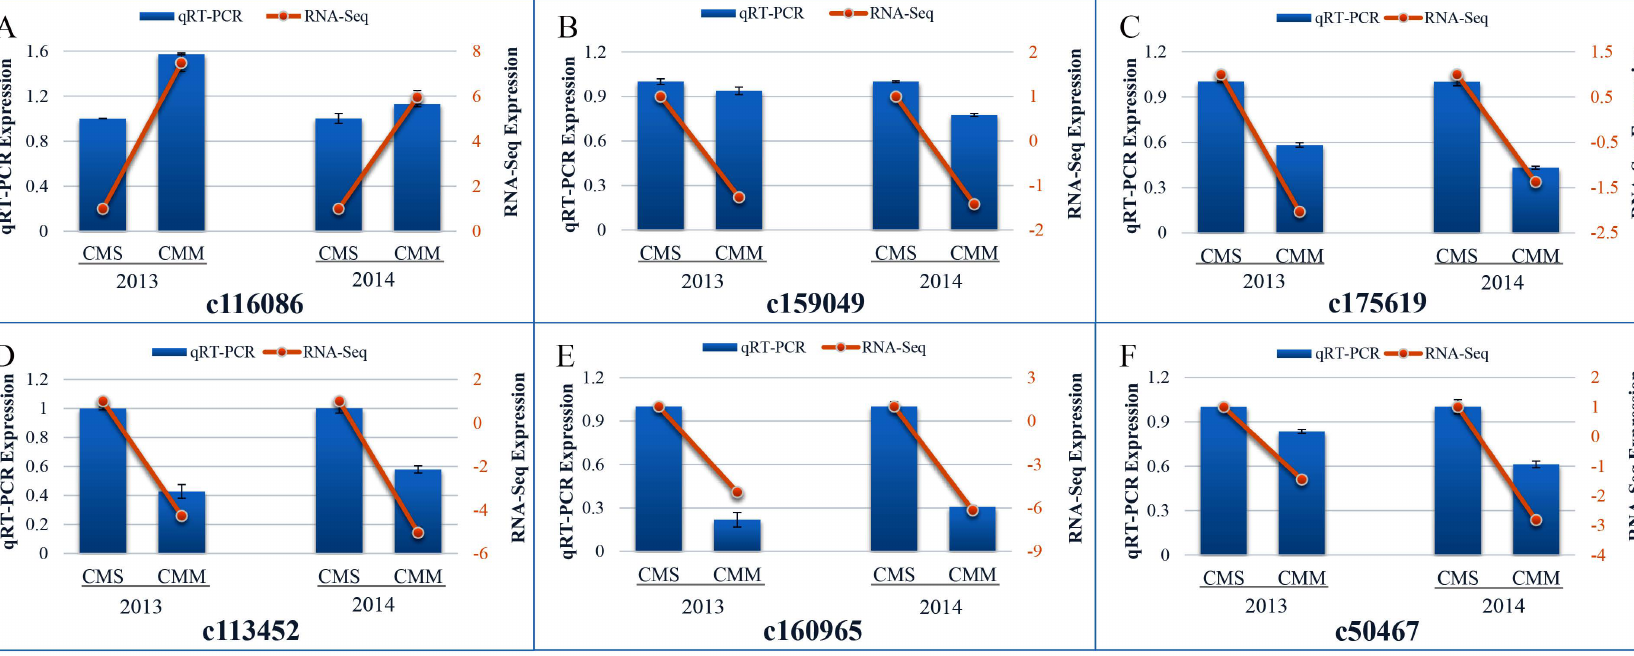
Figure 5. RT-qPCR and RNA-seq verification of differentially expressed candidate unigenes. CMS: Cytoplasmic male sterility; CMM: Cytoplasmic male maintainer. Data represent the average of three independent experiments. Error bars indicate the standard deviation (STDEV) for three biological replicates and three technical replicates in each experiment. ( A – F ) Different unigene IDs: ( A ) c116086; ( B ) c159049; ( C ) c175619; ( D ) c113452; ( E ) c160965; and ( F )